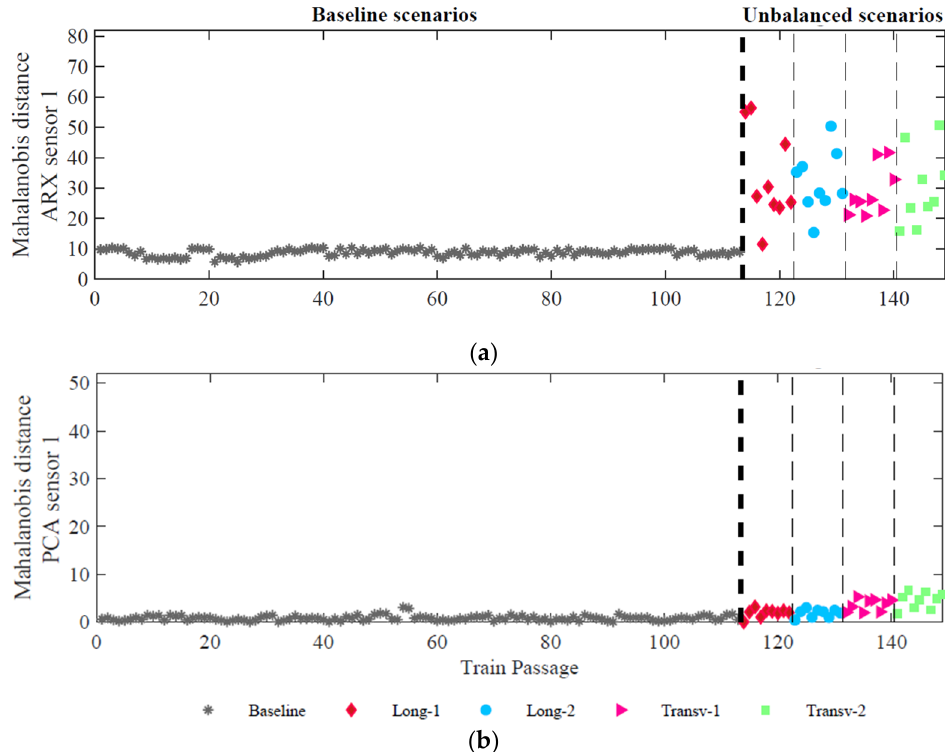
Figure 13. 1st level data fusion—for accelerometer 1: ( a ) ARX features; ( b ) PCA features.